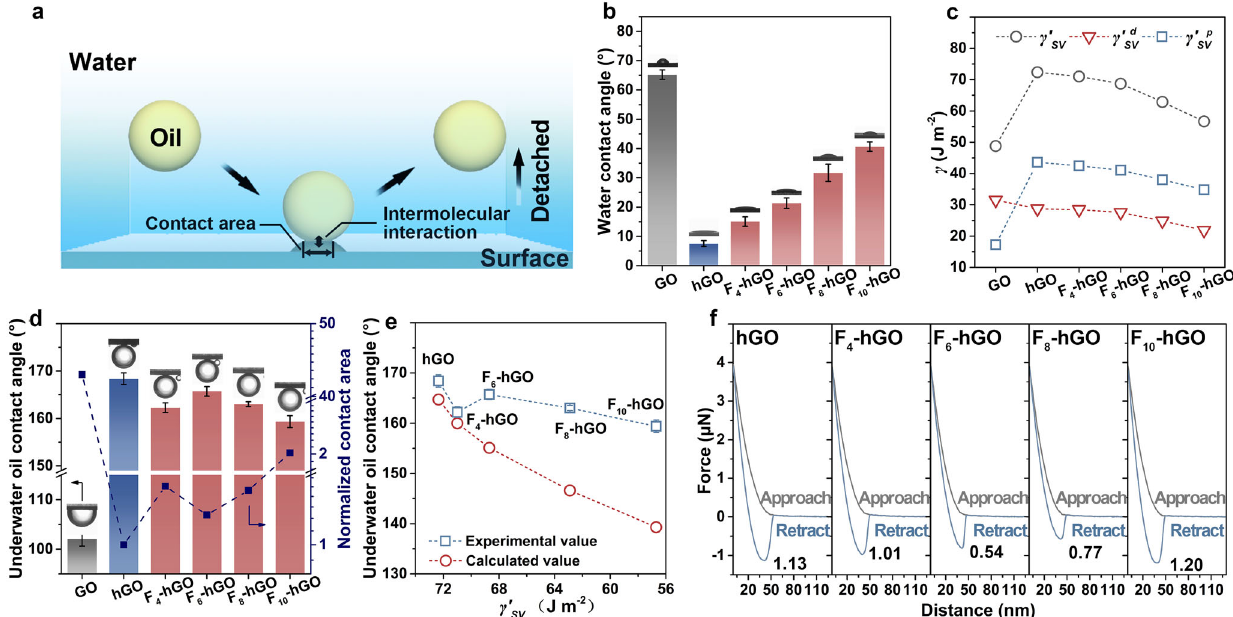
Fig.2|Wettingbehaviorofthemembranes.a Schematicdiagramoftheremoval of oil droplets from a solid surface. b Water contact angles, c apparent surface energy ð γ 0 SV Þ , d underwater oil contact angles and normalized contact areas of the GO,hGO,and F-hGO membranes. The areas are normalized by the contact area of the hGO membrane. e Dependence of the underwater oil contact angle of the